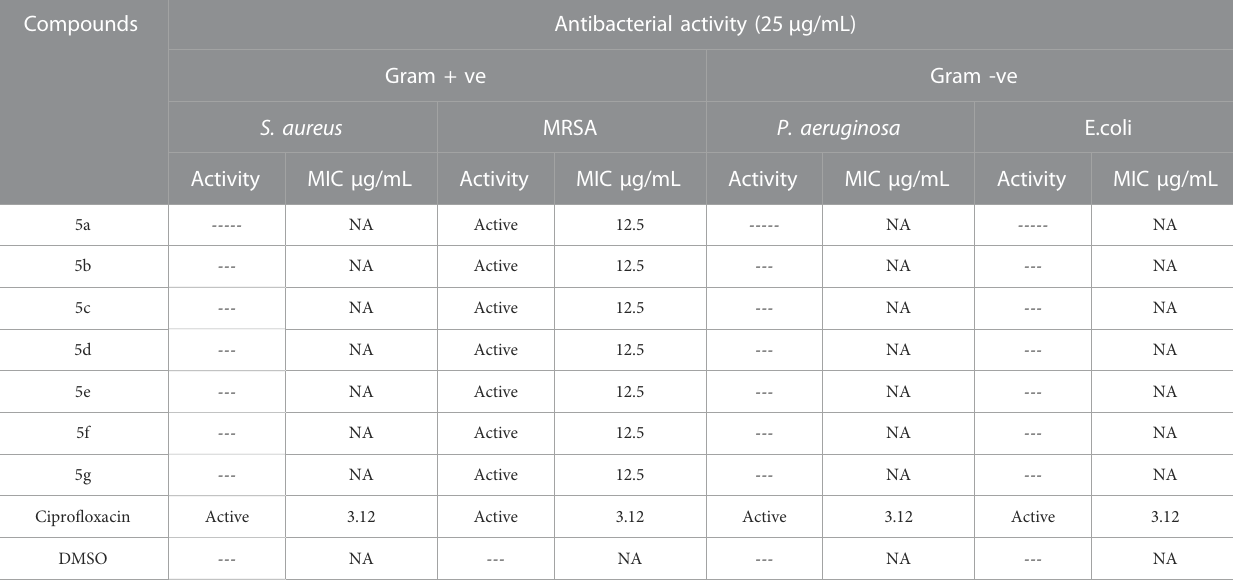
TABLE 3 Antibacterial evaluation of the synthetic compounds of Library compounds (5a-5g) against resistant gram-positive and gram-negative bacteria and their MIC values. Compounds